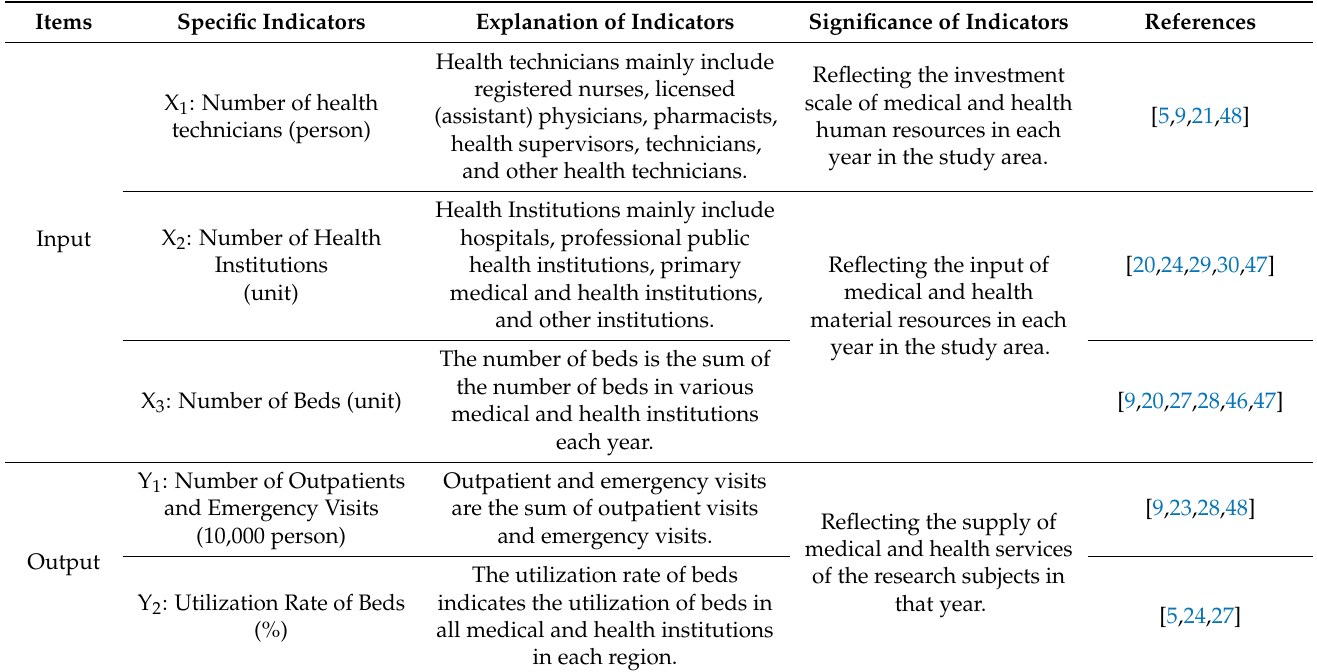
Table 2. The index system of health service efficiency evaluation.